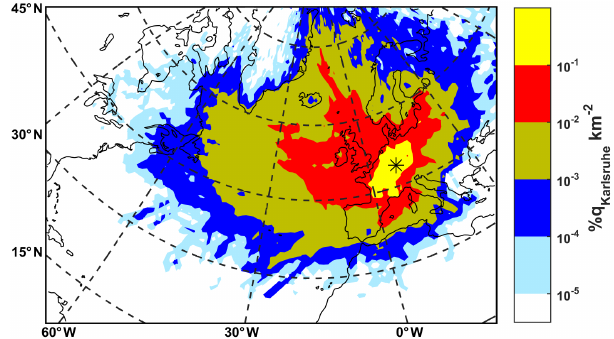
Figure 5. Source regions of moisture ( q ) 30m above ground level in Karlsruhe (black star) based on 5-day back trajectories for the time period January 2012 to May 2013. The color code indicates the contribution of different source regions to q in Karlsruhe in % per km 2 . Integration over the whole map gives the total identified humidity of